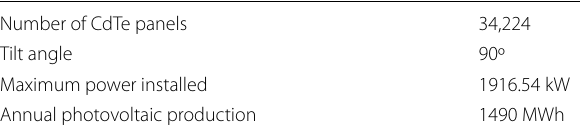
Table 10 Data for cadmium telluride photovoltaic